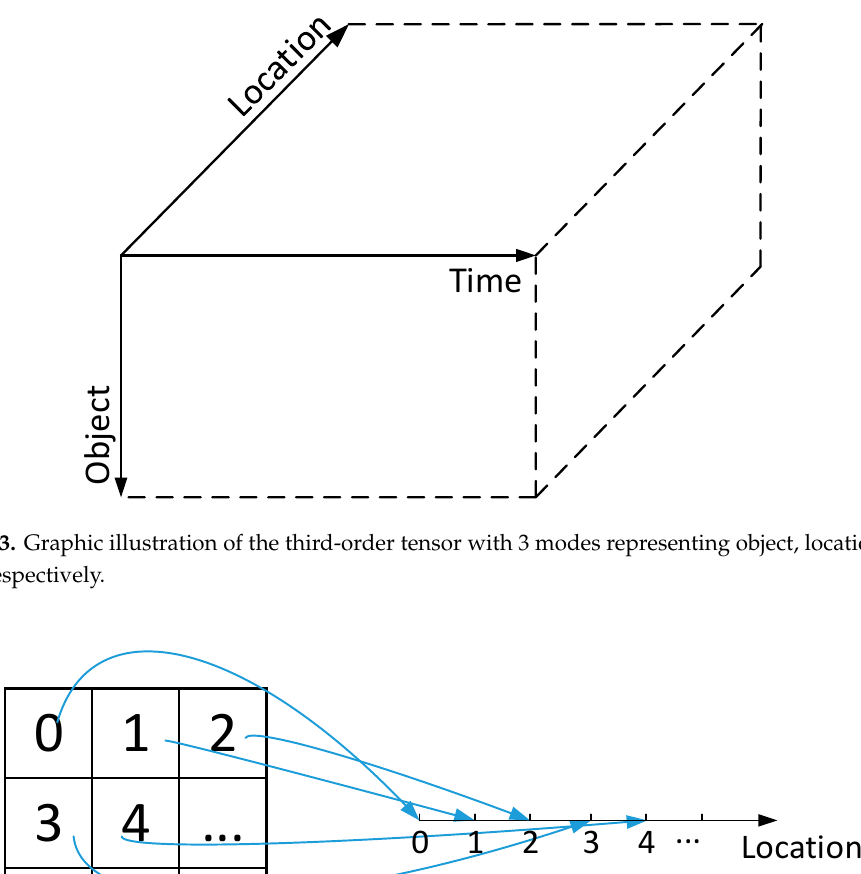
Figure 4. A simple location coding scheme.